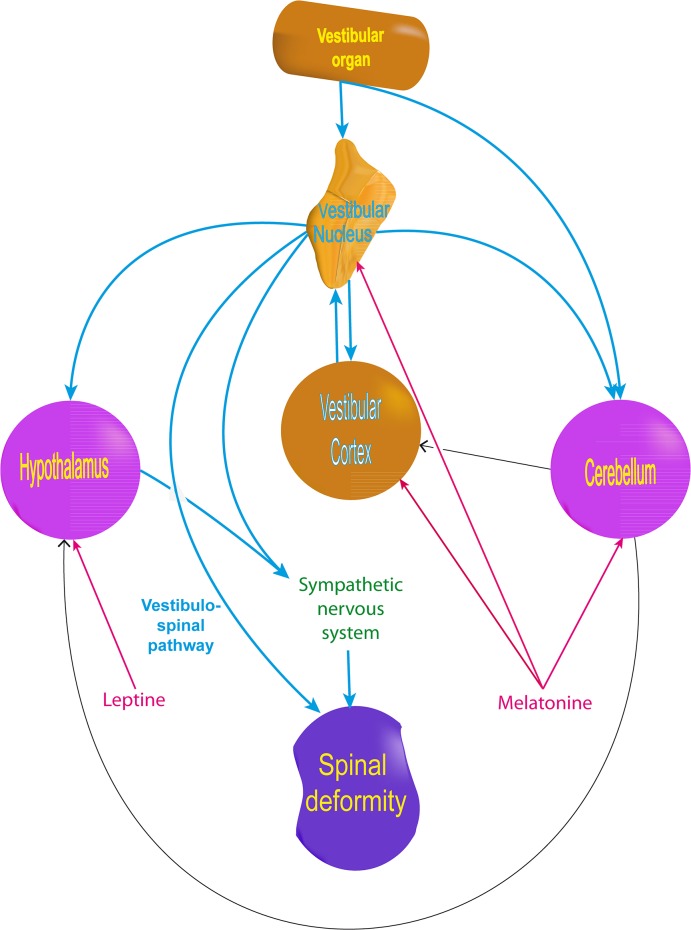
Influence of the vestibular system on key elements involved in AIS pathogenesis theories, including hormonal and neurosensory theories.